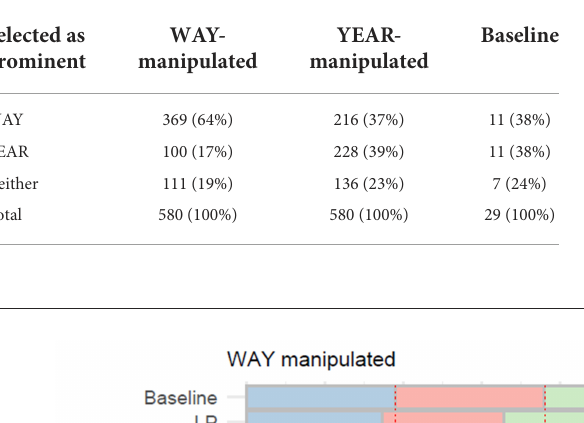
TABLE 2 Summary confusion matrix of perception of the stimuli in Test 1 (count, %).